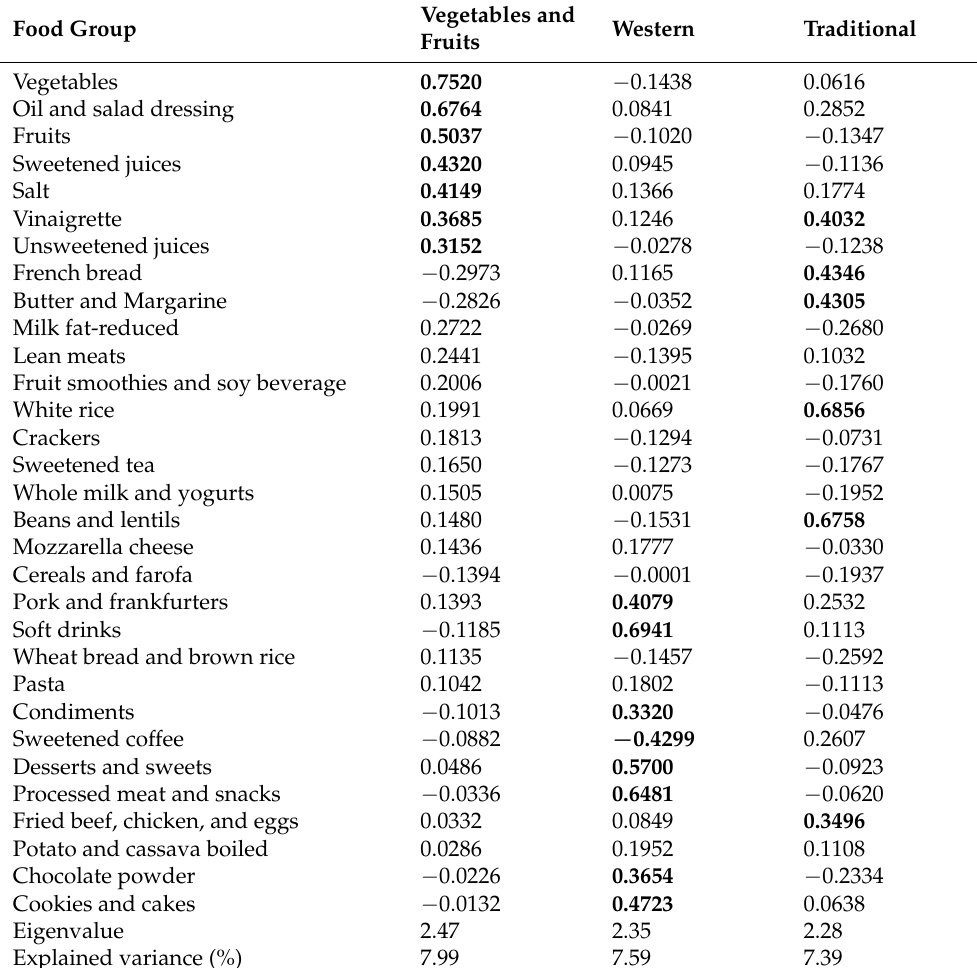
Table 2. Factors loadings of food groups’ characteristic to the principal dietary components identified in 24HR in pregnant women of the ProcriAr Cohort, S ã o Paulo,